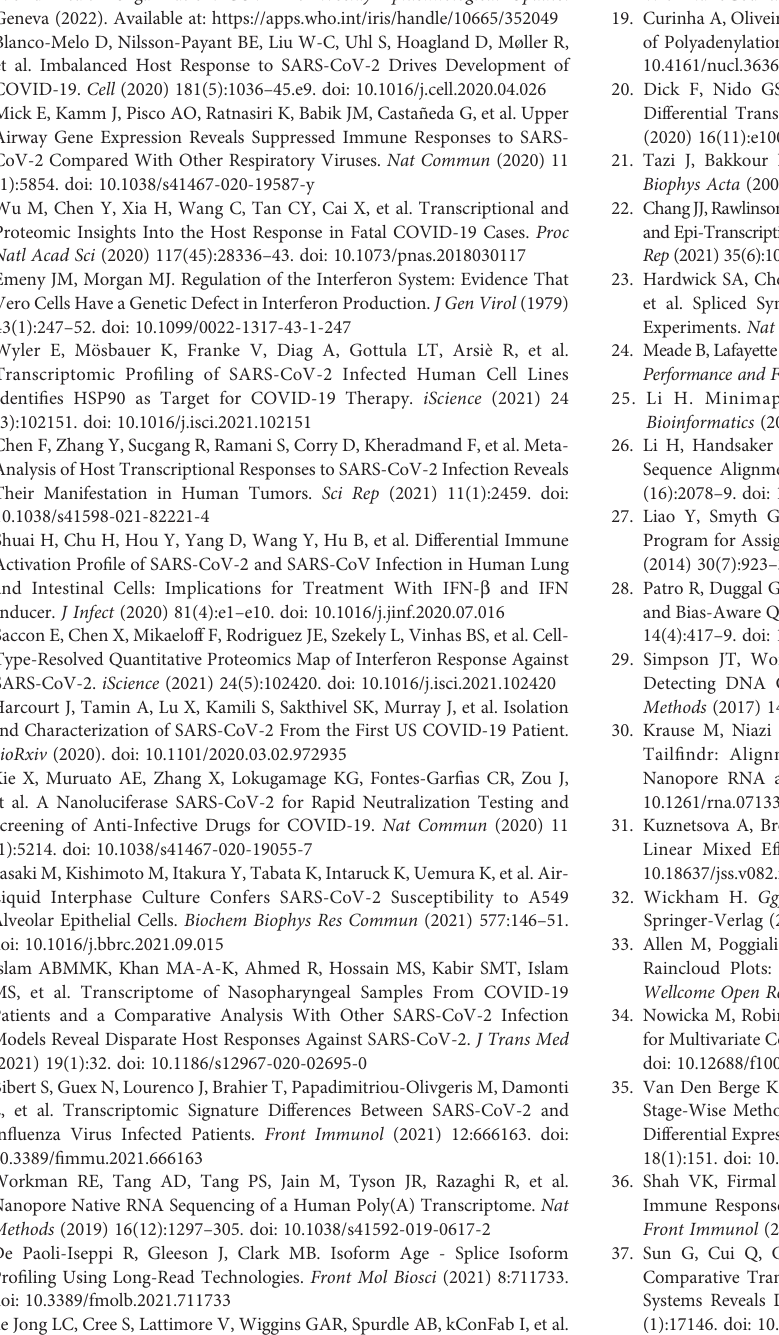
comparable comparedwithtail fi ndrpoly(A)results, asnosigni fi cantpolyadenylation was observed in tail fi ndr poly(A) data. These results suggest that the tail fi ndr poly(T) lengths may be more suitable for estimating differential polyadenylation compared with tail fi ndr poly(A) lengths. Related to Figures S3 and S4 and Table 4